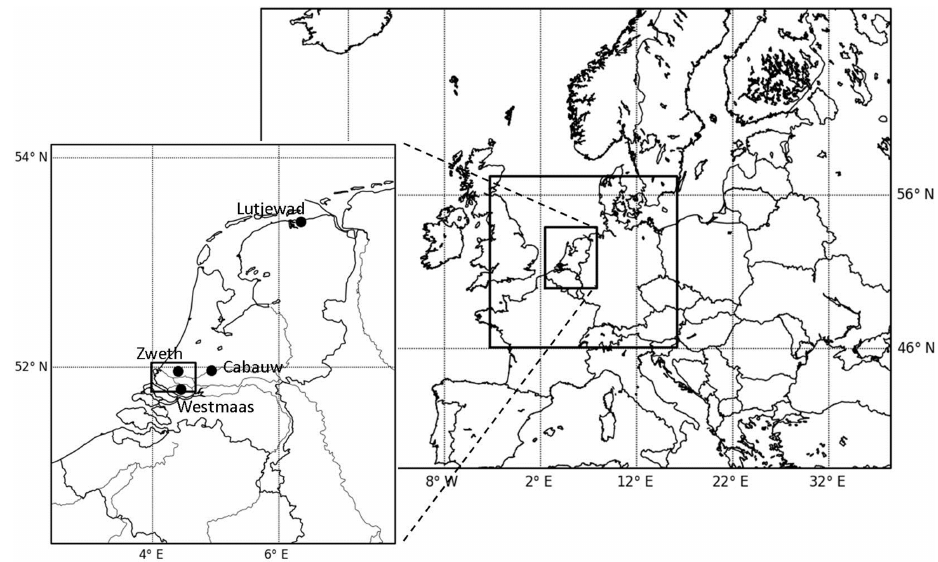
Figure 2. Location of the domains is indicated with squares. The horizontal resolutions of the domains are (from outer to inner domain) as follows: 48km × 48km, 12km × 12km, 4km × 4km and 1km × 1km. Black circles represent the observation sites.